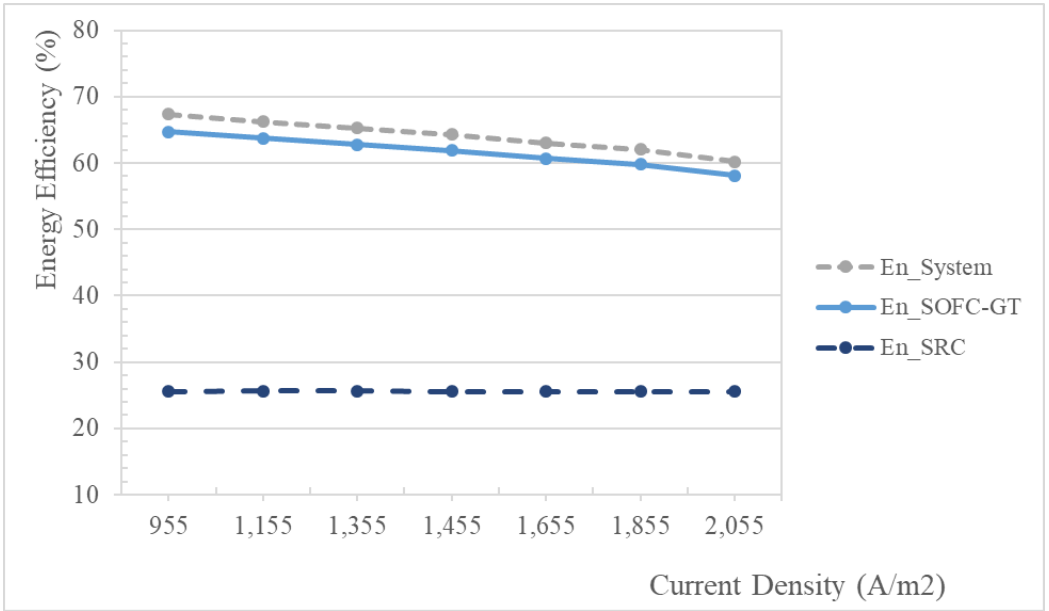
Figure 4. Effect of current density on the energy efficiency of system.